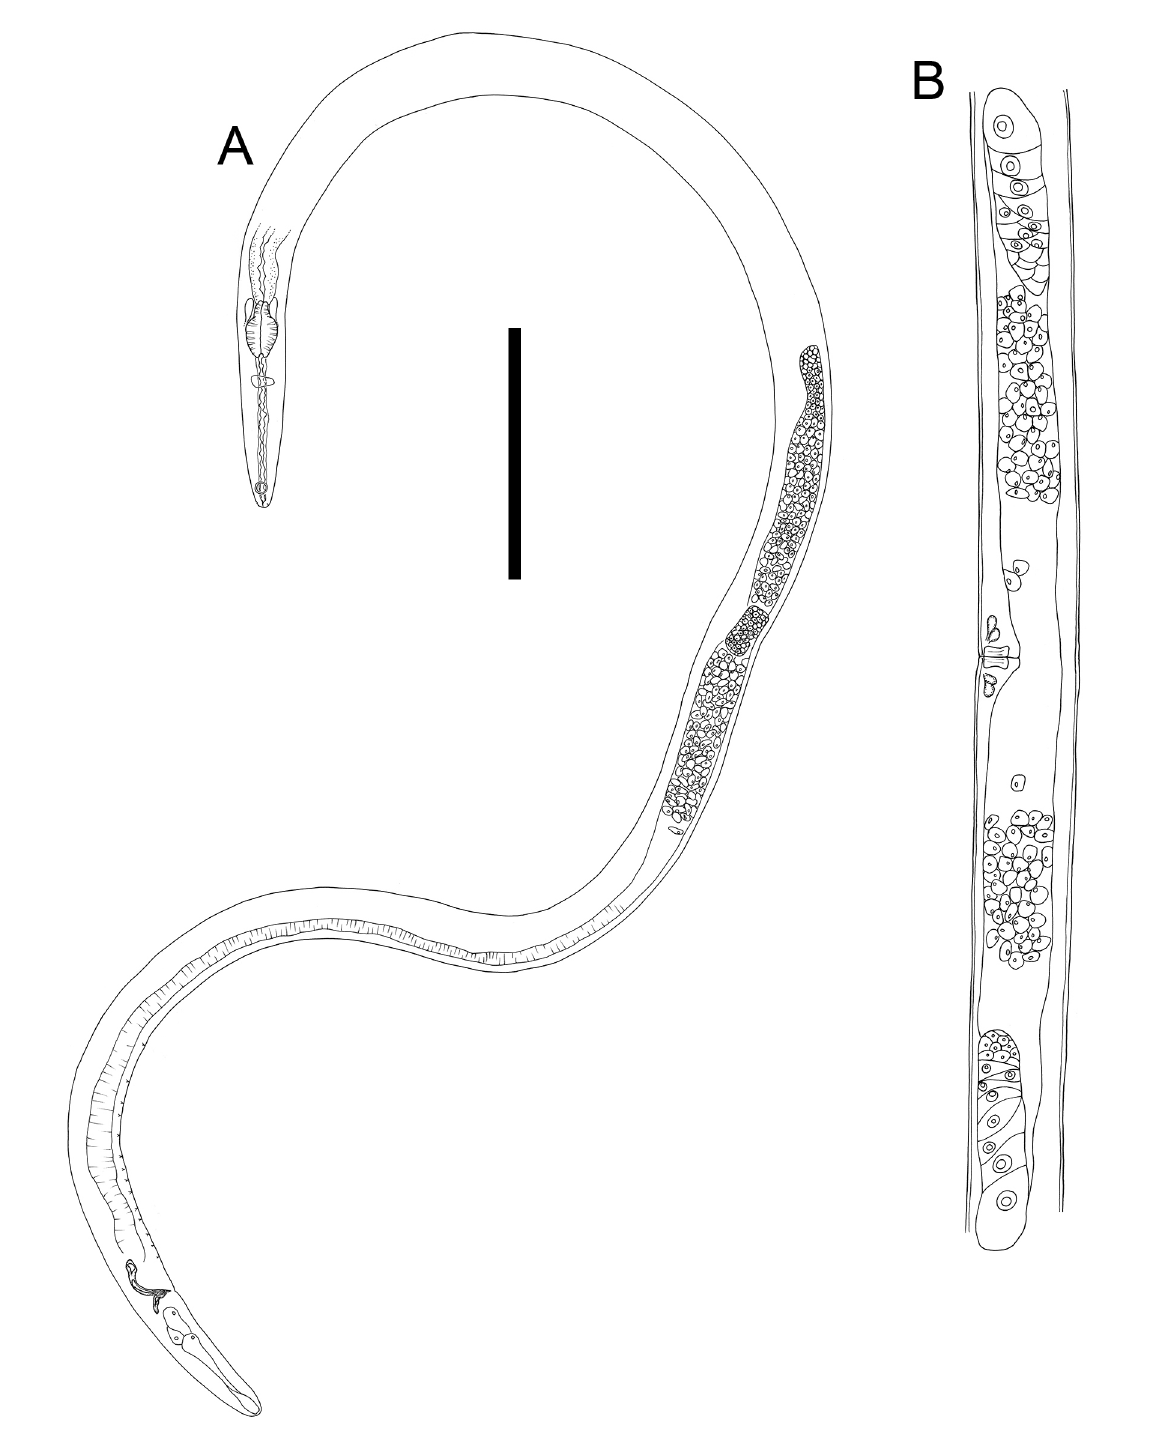
Fig. 14. Aegialoalaimus magnus sp. nov. A . Entire male, holotype (NIWA154918). B . Female reproductive system, paratype (NIWA154920). Scale bar: A = 300 µm; B =